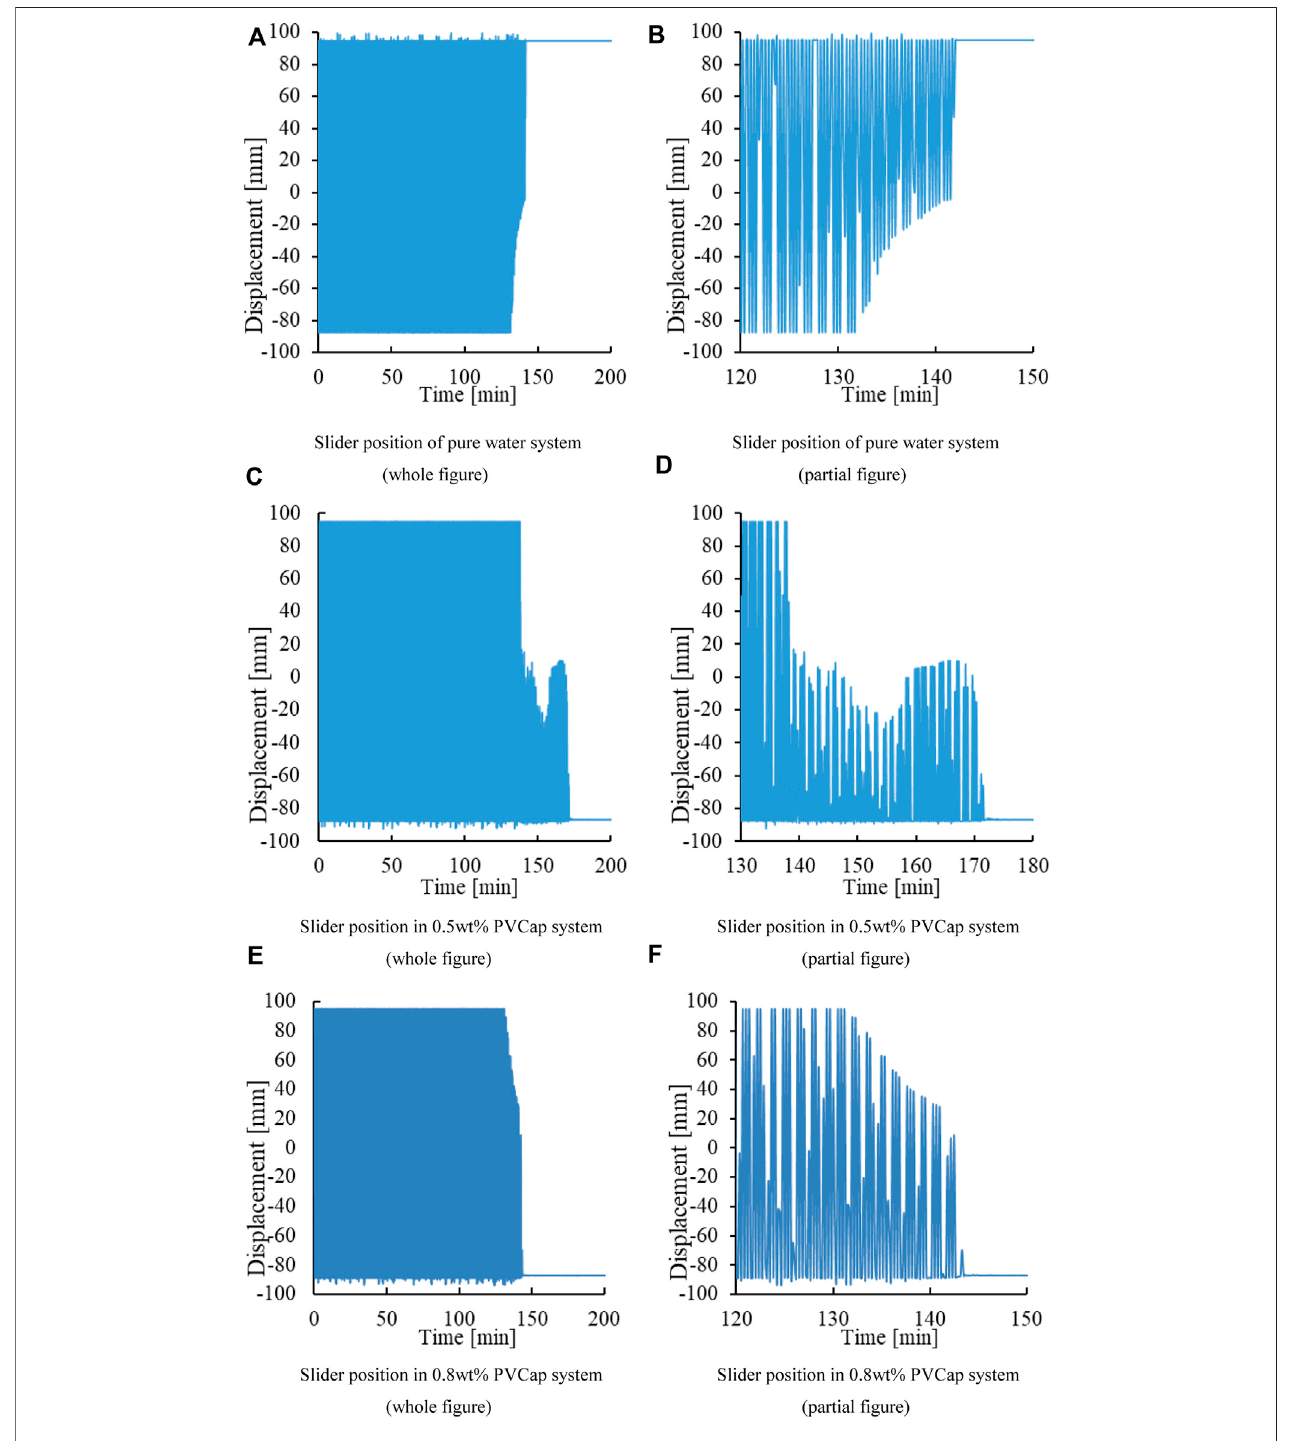
FIGURE 5 | Slider positions in pure water and PVCap solutions. (A) Slider position of the pure water system (whole fi gure). (B) Slider position of the pure water system(partial fi gure). (C) Sliderpositioninthe0.5wt%PVCapsystem(whole fi gure). (D) Sliderpositioninthe0.5wt%PVCapsystem(partial fi gure). (E) Sliderpositionin the 0.8wt% PVCap system (whole fi gure). (F) Slider position in the 0.8wt% PVCap system (partial fi gure).